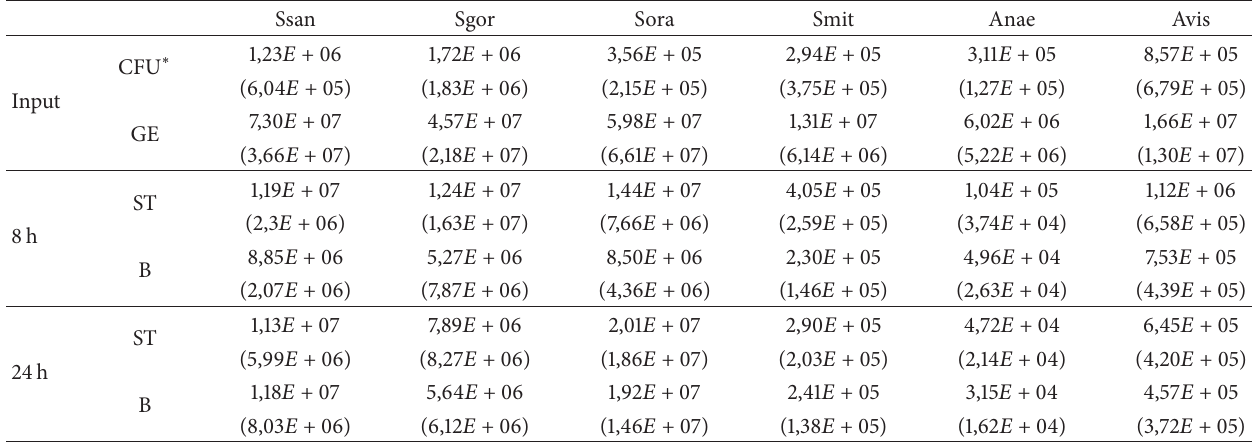
Table 5: Results of the in vitro adhesion assay after 8 h and 24h. Amounts (mean (StDev)) of A. viscosus (Avis), A. naeslundii (Anae), S. mitis (Smit), S. oralis (Sora), S. gordonii (Sgor), and S. sanguinis (Ssan) on materials ST and B.